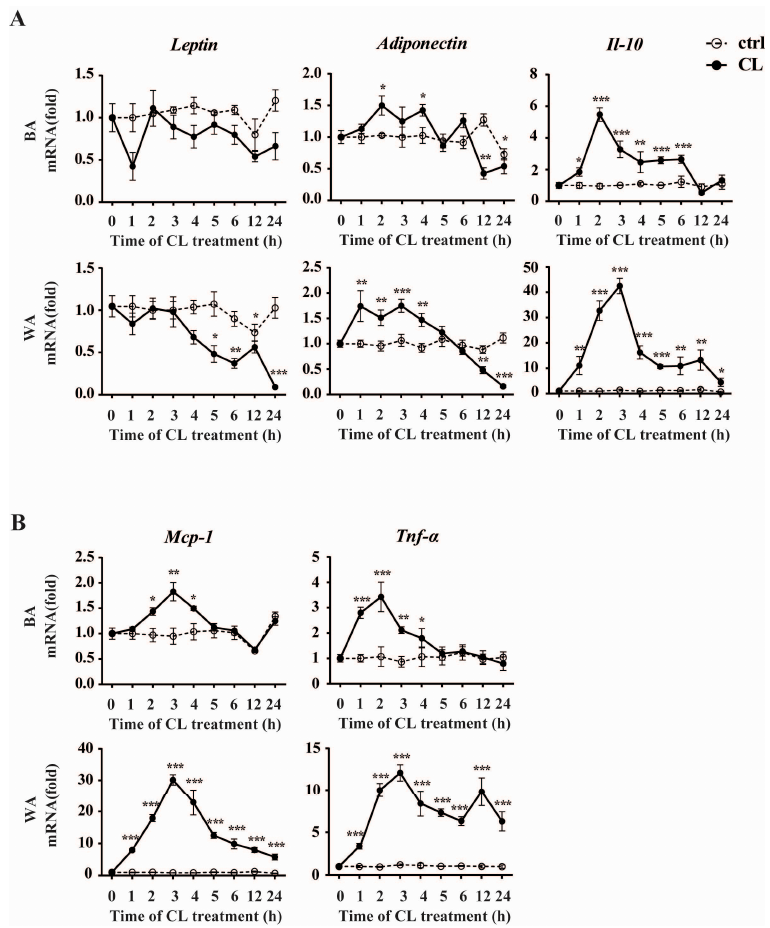
Figure 5. CL316,243 treatment alters the expressions of inflammatory adipokines in BA and WA. Quantitative PCR analysis of anti-inflammatory ( A ) and pro-inflammatory ( B ) adipokines expression in cultured mice BA and WA after CL316,243 treatment up to 24 h. The data show the fold changes of the expression for the target genes in BA and WA at Hour 0. Values are mean ± S.E.M. from three independent experiments. The expression of genes is corrected for the housekeeping gene Cyclophilin (* p < 0.05, ** p < 0.01, *** p < 0.001).